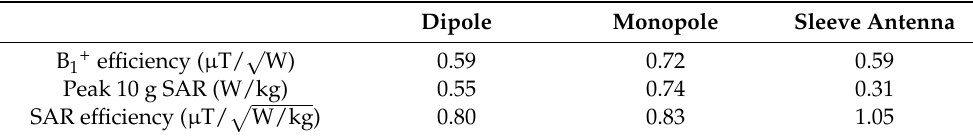
Figure 3. CAD models ( a , b ) and photographs ( c , d ) of the 8-channel monopole and sleeve antenna arrays. Table 1. Quantitative comparison of B 1+ efficiency, 10 g SAR, and SAR efficiency among the 8- channel dipole, monopole, and sleeve antenna arrays with human model in the ROI marked for the highest